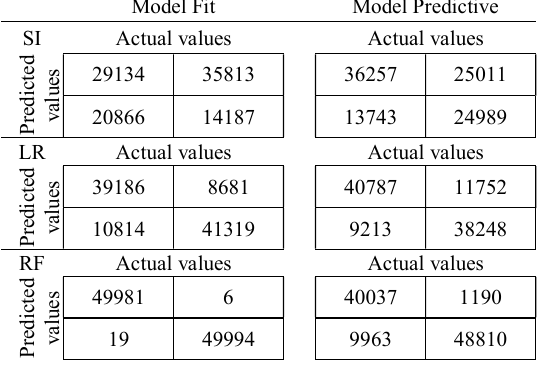
Table 1. Confusion matrices for the three models